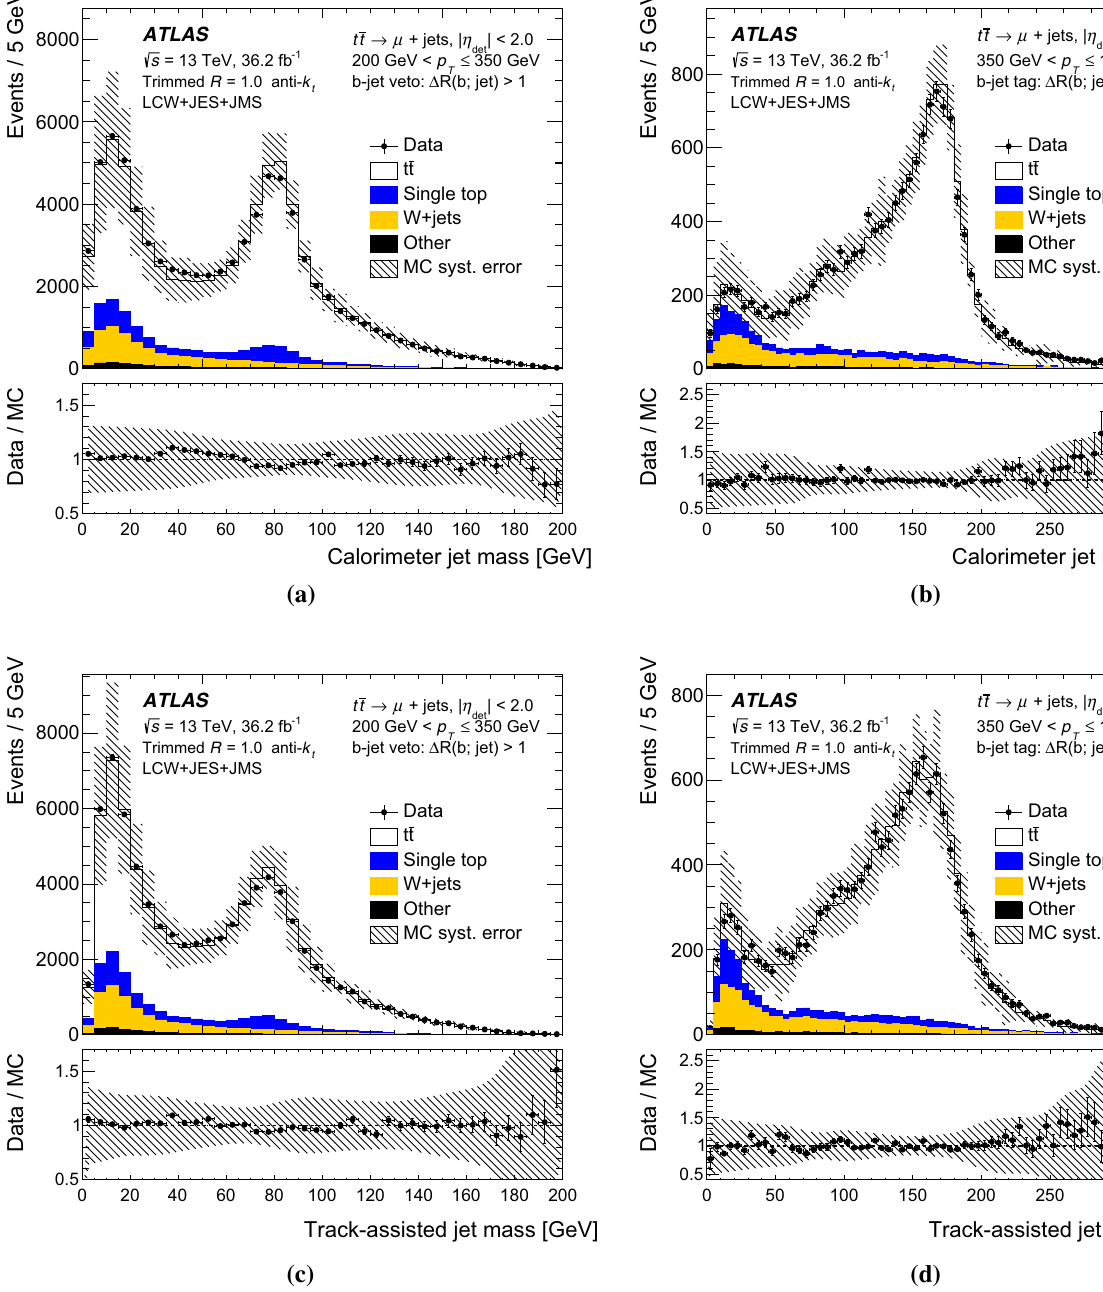
Fig. 19 The distributions of the jet invariant mass for large- R jets in samples enriched in a , c boosted W bosons and b , d boosted top quarks. The distribution of the calorimeter mass is shown in ( a ) and ( b ), and the distribution of the track-assisted mass of the same jets is shown in ( c ) and ( d ). The large- R jet transverse momentum p T is corrected using the simulation calibration, η -intercalibration, and a combination